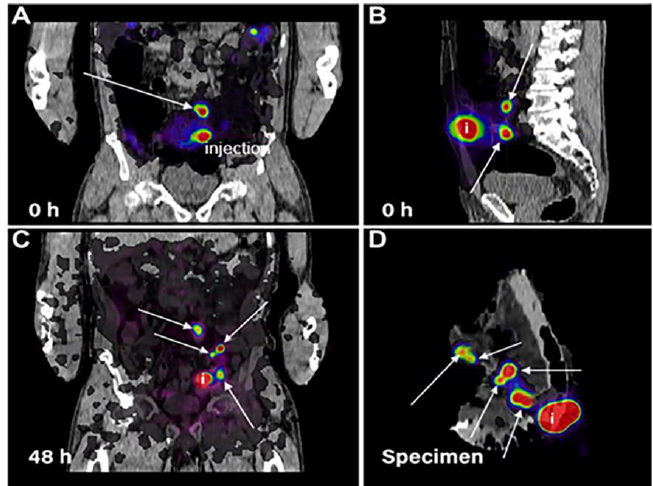
Figure 4. PET-CT identification of sentinel lymph nodes following injection of colloidal albumin radiolabeled with 89 Zr. Arrows indicate positive disease. Top images of the frontal ( A ) and sagittal ( B ) plane immediately following injection of radiotracer show foci. By 48 h post-injection ( C ), lymph node foci are clearly visible, prior to surgery. Static PET-CT of the specimen following surgery corroborates pre-operative images ( D ). i represents location of injection. Reprinted/adapted with permission from [135].